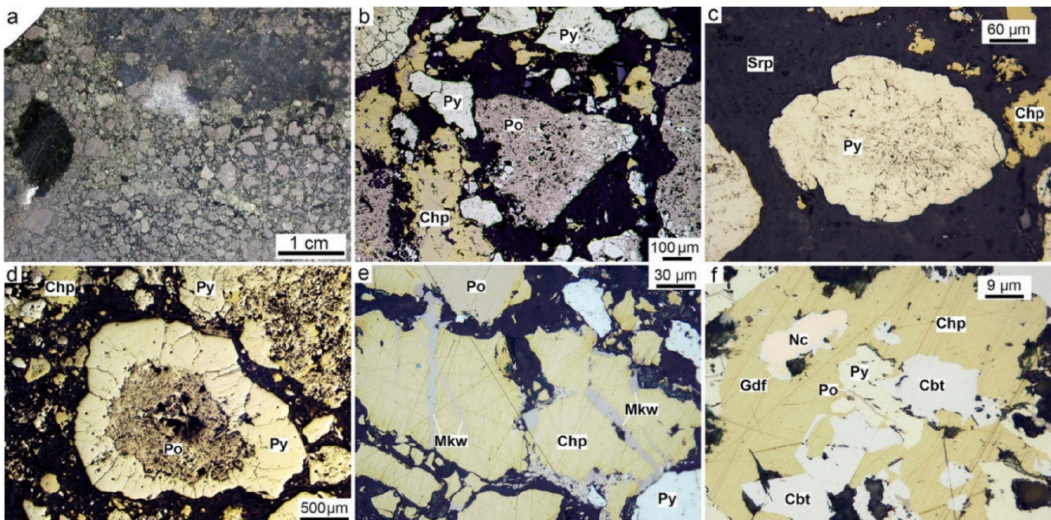
Figure 5. Pyrrhotite-rich diagenite after an altered sulfide sandstone mixed with serpentinite clasts of the Dergamysh deposit: ( a ) General view; ( b ) pseudomorphic pyrrhotite and chalcopyrite after ore clasts; ( c ) pyrite nodule in serpentine; ( d ) pyrrhotite–pyrite nodule; ( e ) mackinawite veinlets in anhedral chalcopyrite; ( f ) nickeline grain rimmed by gersdorffite in anhedral chalcopyrite nearby cobaltite and pyrite crystals. ( a ) Polished sample, ( b – f ) reflected